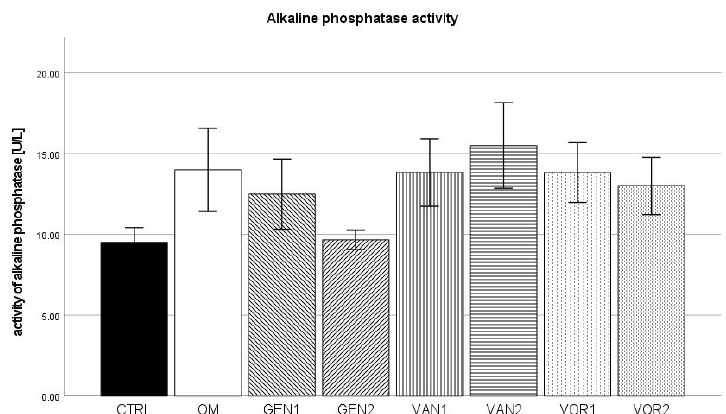
Figure 8. Mean AP activity per group as measured in the cell culture medium. The error bars show the error of mean.